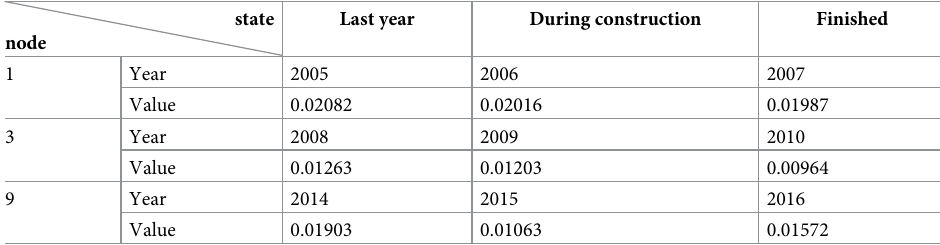
Table 3. Annual average VSWI within the 1km radius of each interchange node before and after its construction (Show only part, S1 Table for complete table). state Last year During construction Finished node